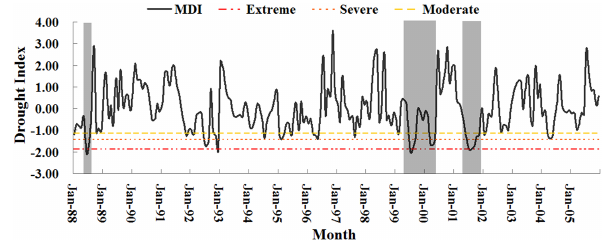
Figure 3. Monthly time series of MDI for Huaihe River